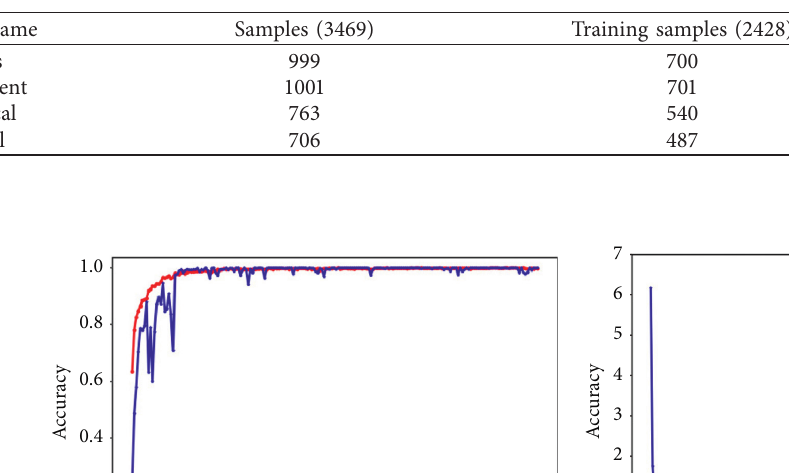
Table 2: Sample number of atmospheric particles and the number of training and testing samples in Attention-CNN.